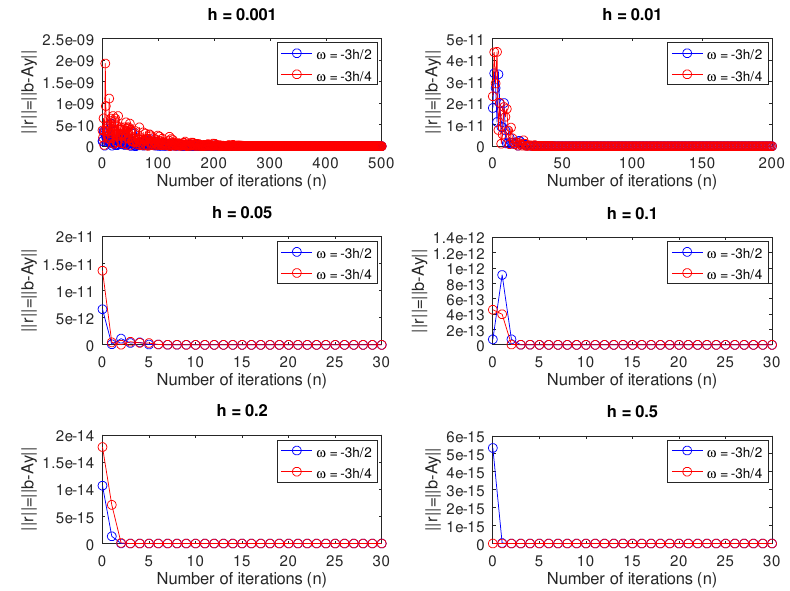
Figure 13. Comparison of the norm of the residual for different values of step sizes using the discrete schemes (3)–(6) corresponding to ω = 3 h ω = . 2 −